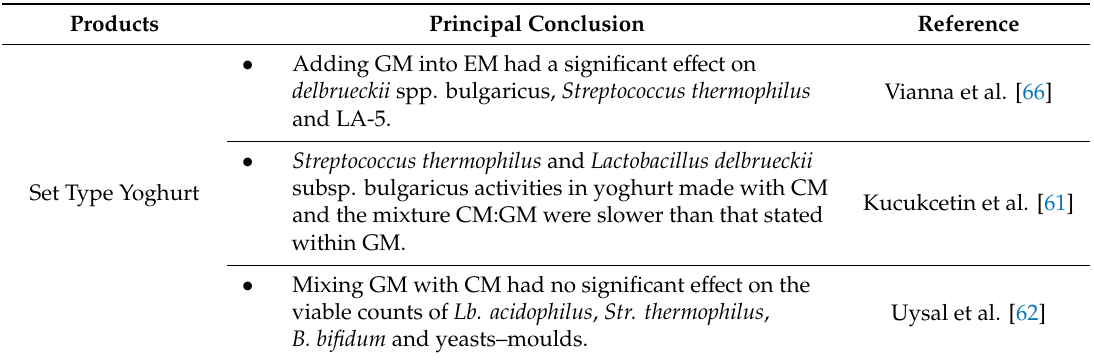
Table 4. Examples of principal conclusions of studies concerning the e ff ect of mixing milk from di ff erent species at di ff erent proportions on microbiological properties of